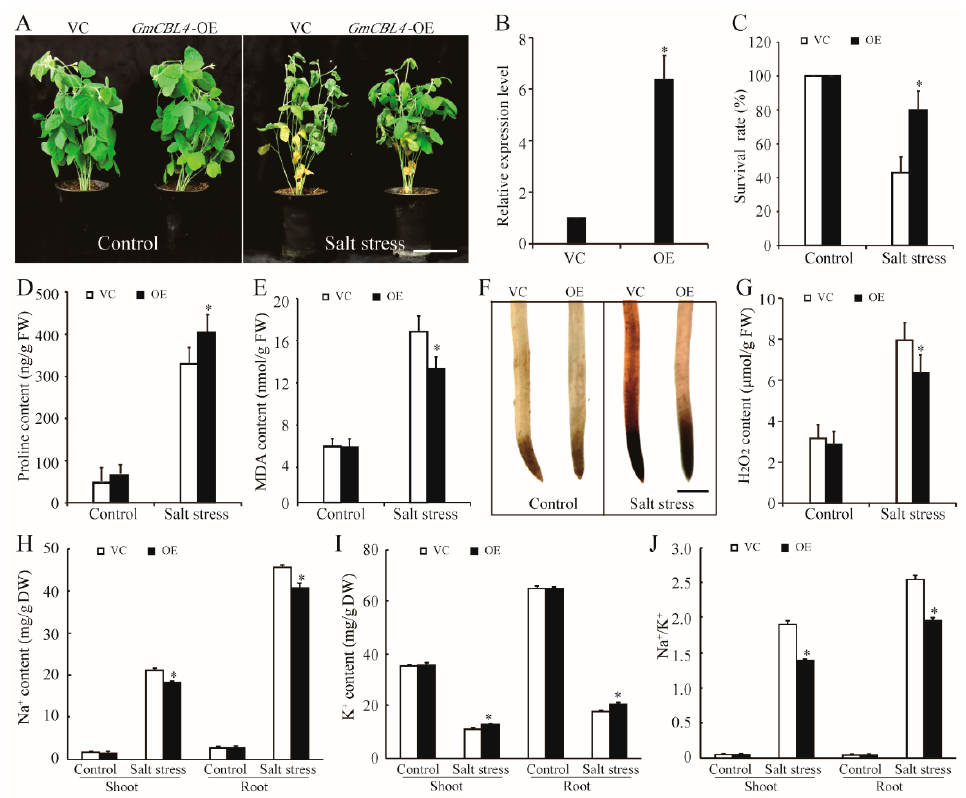
Figure 6. GmCBL4 confers salt tolerance in hairy roots. ( A ) Analyses of the salt tolerance in OE and VC plants under salt treatment. ( B ) Measurement of the transcript of GmCBL4 in hairy roots ( C ) Survival rates ( D ) proline contents, and ( E ) MDA contents of OE and VC hairy roots under salt treatment. ( F ) DAB staining and ( G ) H 2 O 2 contents, ( H ) Na + contents, ( I ) K + contents, and ( J ) Na + /K + ratios in the hairy roots of OE and VC plants under salt treatment. Bar = 0.1 cm. Each data point represents the mean (±SE) of three independent biological replicates. The * represents significant differences with the corresponding controls (* p < 0.05).